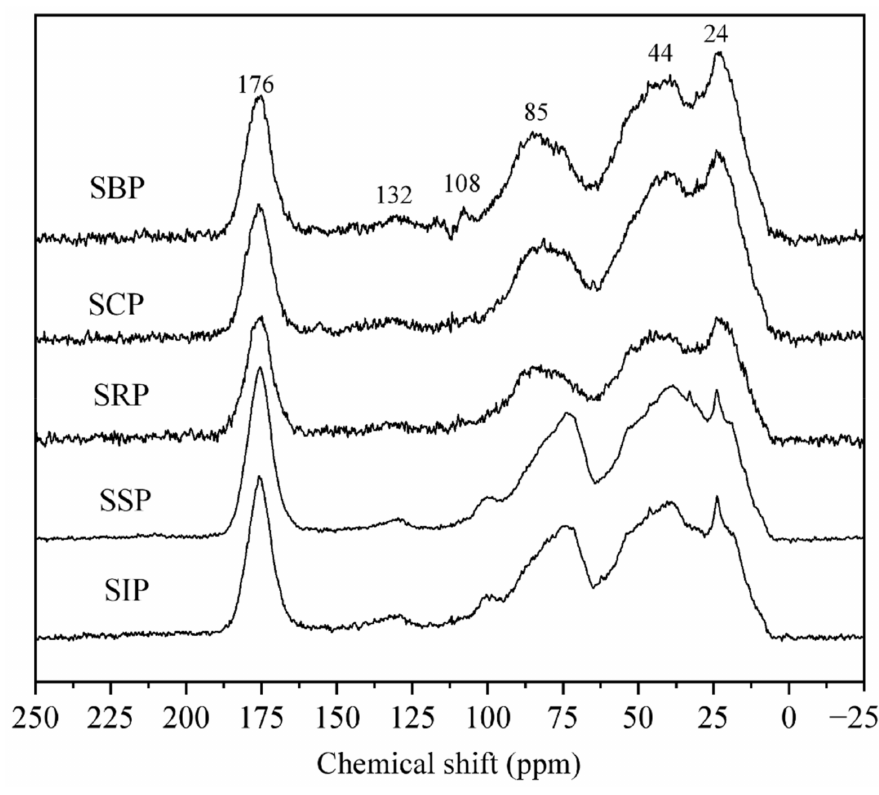
Figure 4. 13 C NMR spectra of DOM samples. Table 3. The relative carbon percentage of DOM functional groups and compound classes (total aliphatic and total aromatic) obtained from 13 C NMR